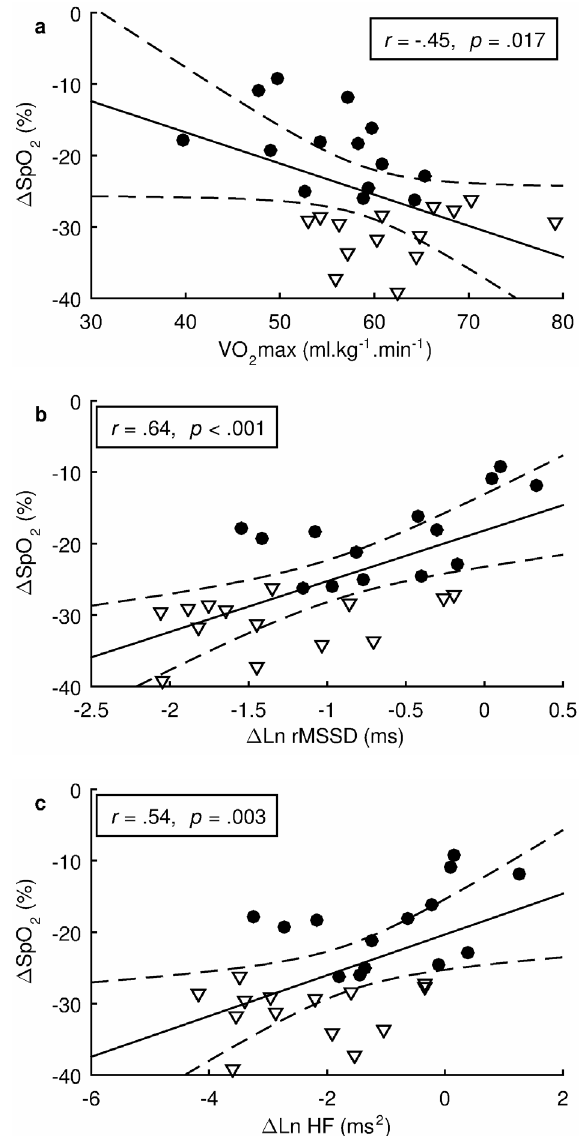
Figure 3. Correlation analysis between oxygen desatu- ration (ΔSpO = SpO – SpO ) and the 2 2 Hypoxia 2 Preliminary max value (a), the change in the natural logarithm VO 2 of square root of the mean of the squares of the succes- sive differences (b, ΔLn rMSSD = Ln rMSSD – Ln Hypoxia rMSSD ), and the change in the natural logarithm Preliminary of high-frequency power (c, ΔLn HF = Ln HF – Ln Hypoxia HF ). Circle mark = resistant group (saturation Preliminary during hypoxia ≥ 70.9%, n = 14); triangle mark = sensi- tive group (saturation during hypoxia < 70.9%, n = 14). Dashed lines denote 0.95-confidence interval.